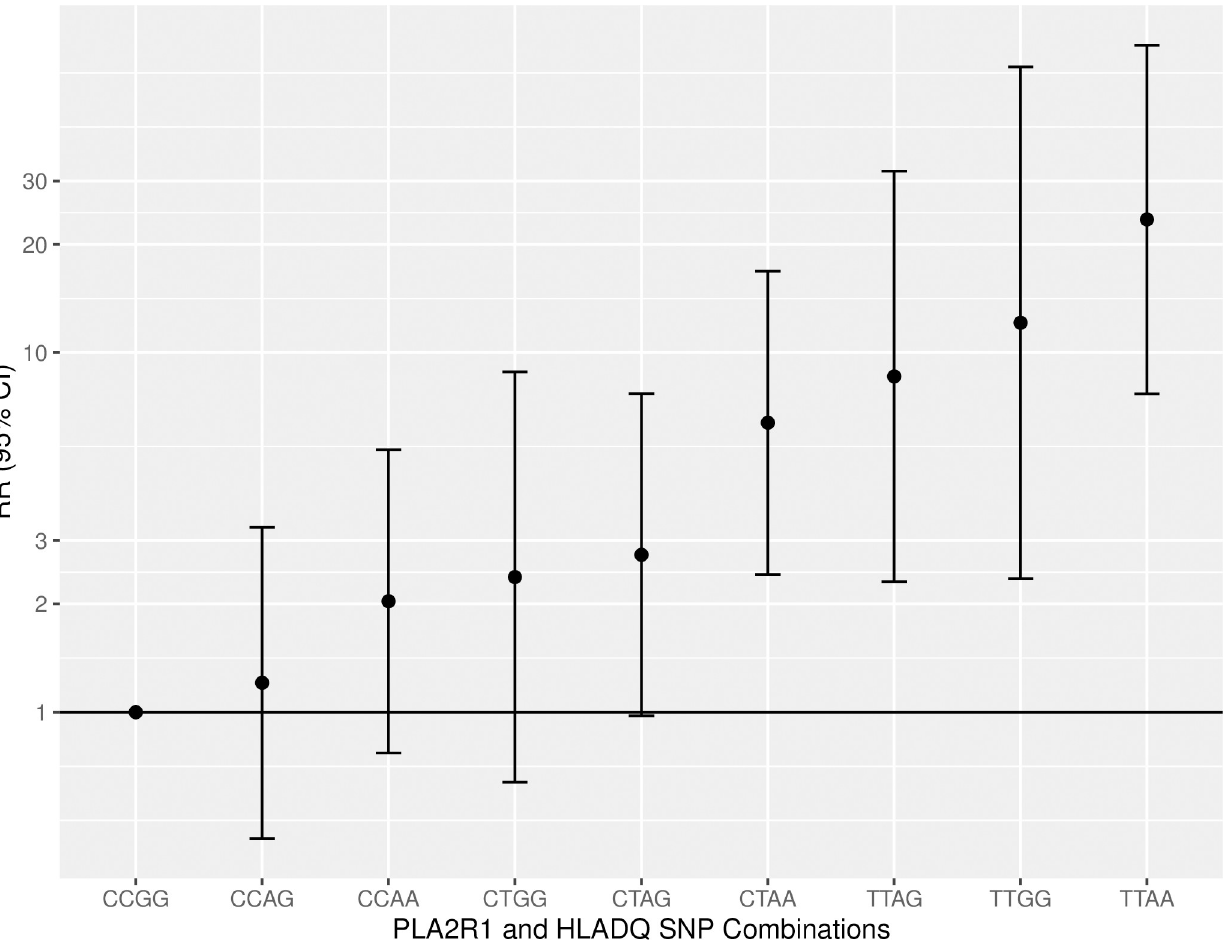
Fig 2. Genetic Risk of MN by PLA2R1 and HLADQ. Based on directly called SNPs determined in GWAS1 4 .